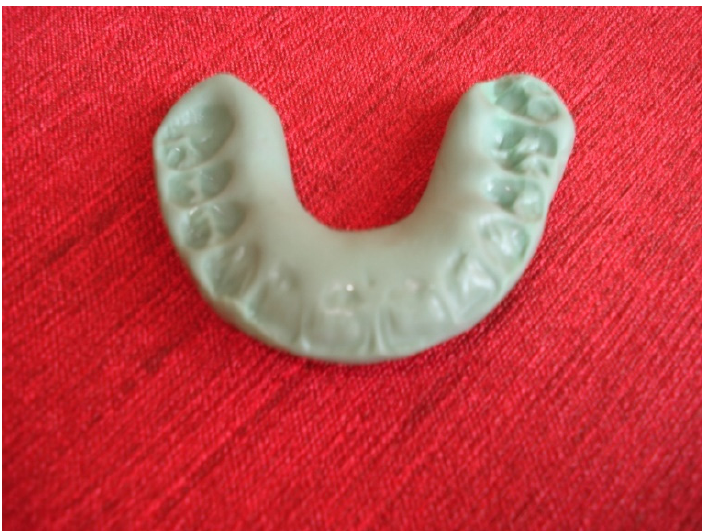
Figure 1. Temporary anterior repositioning appliance made of impression material.